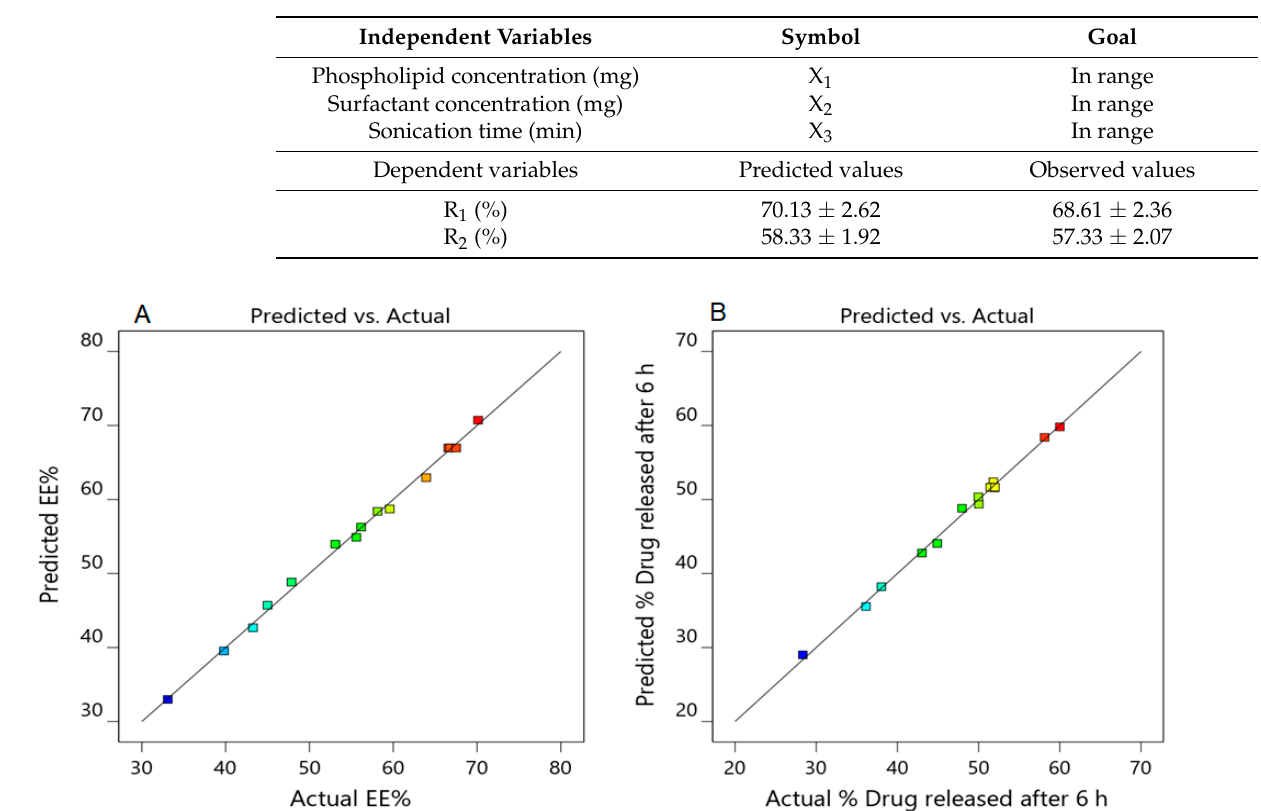
Table 3. Predicted and observed results of the optimized Silymarin loaded transfersomes formulation.